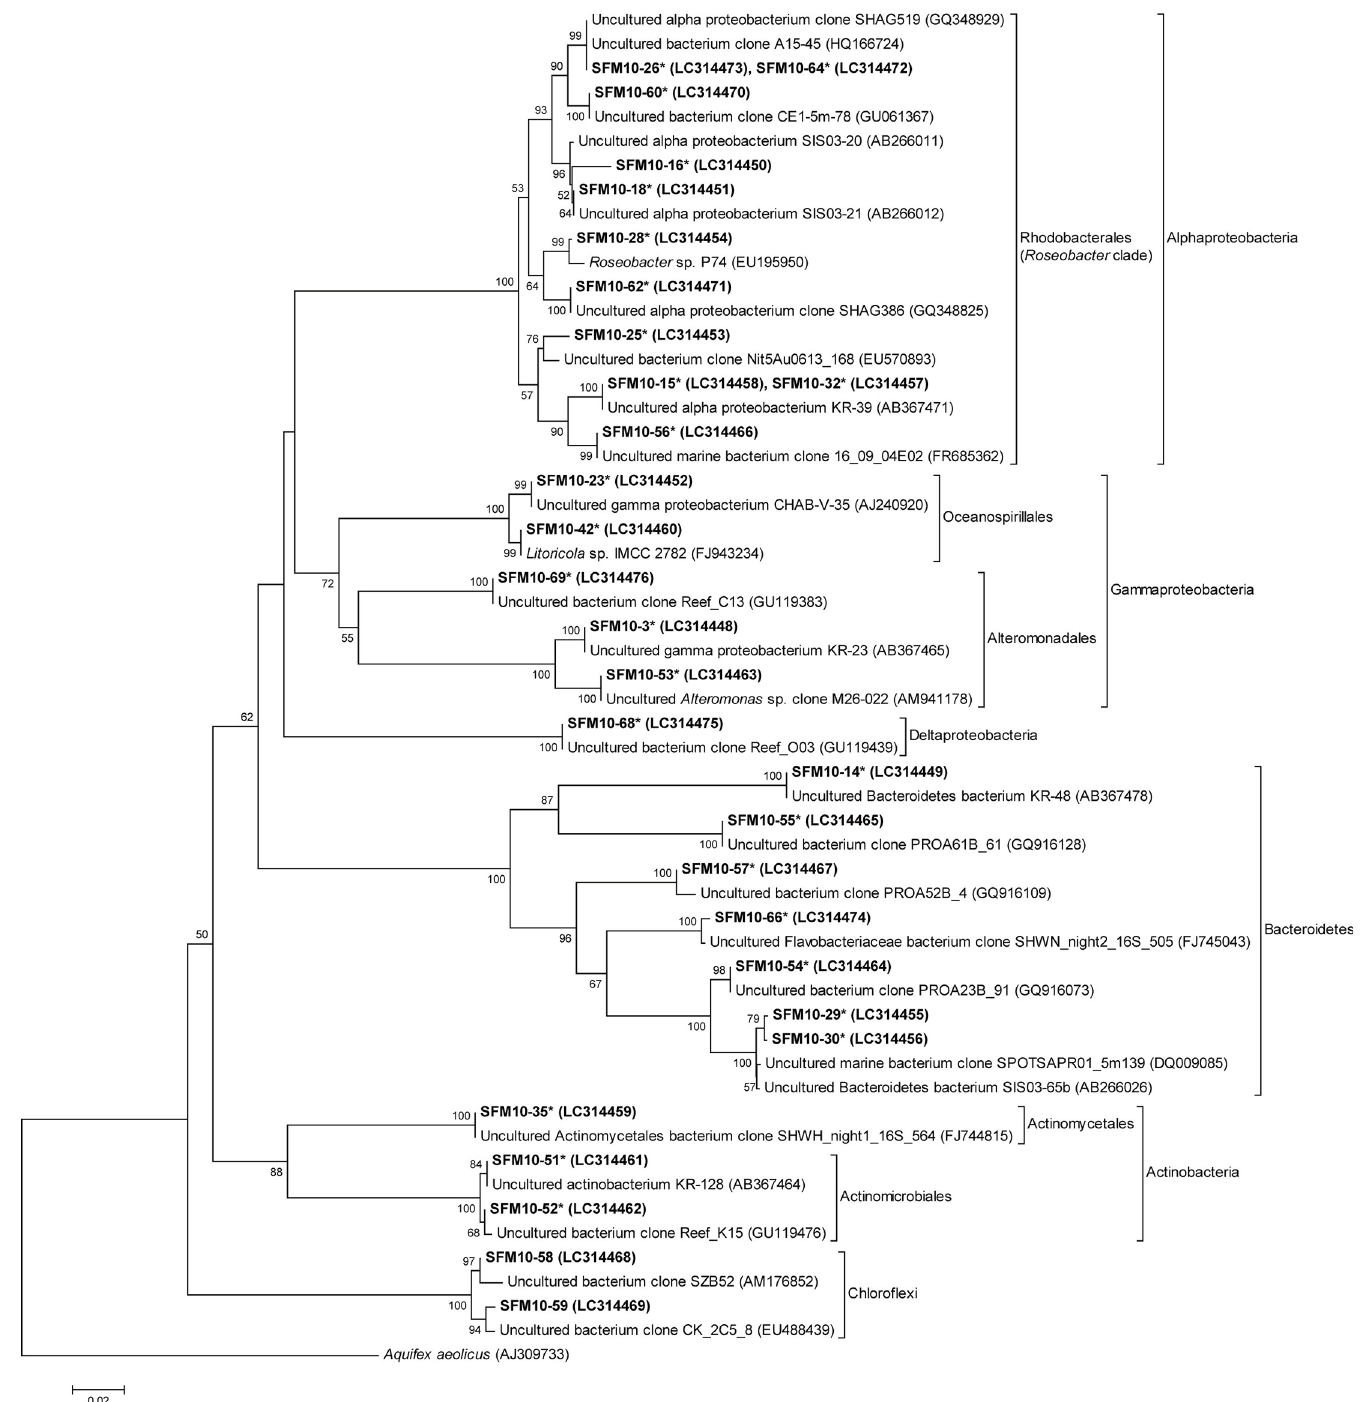
Fig 4. Neighbor-joining tree of partial sequences of 16S rRNA genes in excised denaturing gradient gel electrophoresis bands and their closest relatives. Sequences determined in this study are shown in bold. Bootstrap values ( > 50%) are indicated by branches. The scale bar represents 2% estimated sequence divergence. Asterisks indicate the phylotypes found in BrdU-incorporating communities. Aquifex aeolicus was used as the outgroup.